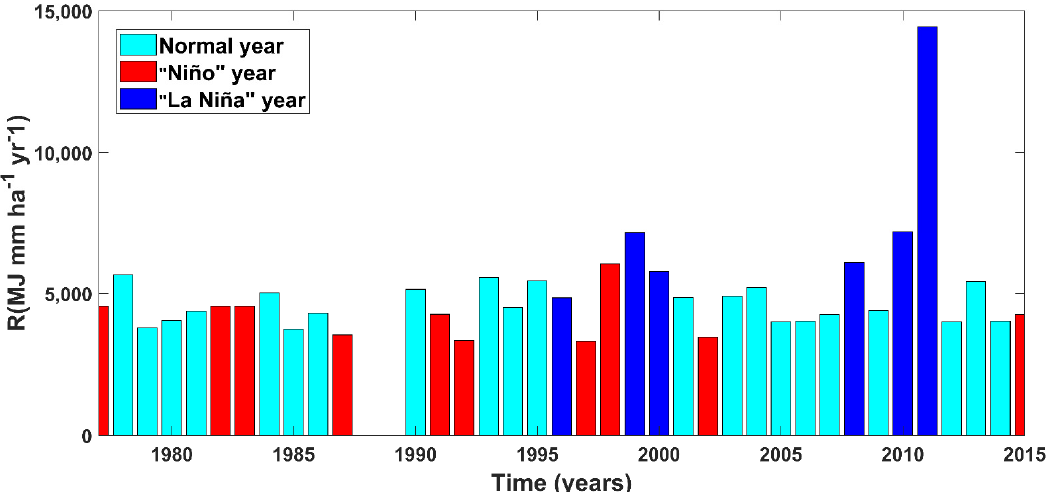
Figure 4. Rainfall erosivity factor, R . Color codes indicate normal, el Niño and la Niña years.